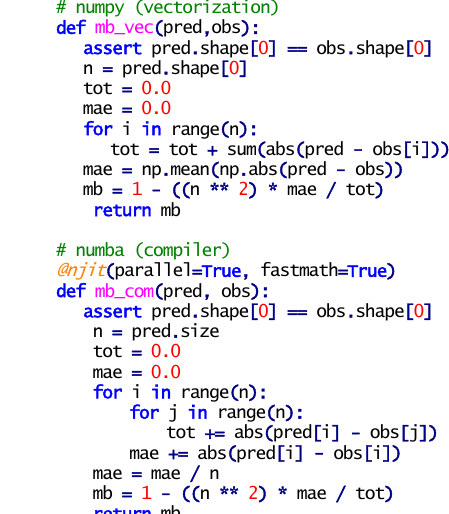
Figure 6. Three different coding approaches to implementing the Mielke–Berry error metric which Figure 6.